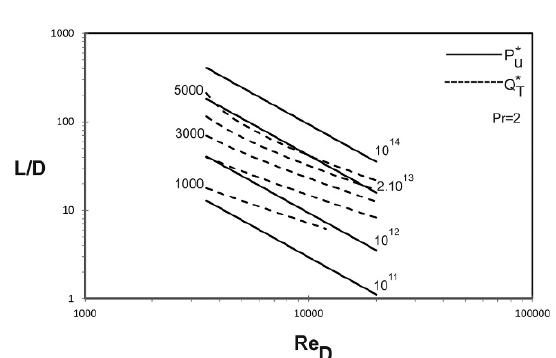
Figure 6. L/D group versus the Reynolds number for different di- mensionless heat transfer conductance and fluid pumping power (turbulent regime and prescribed wall temperature boundary)